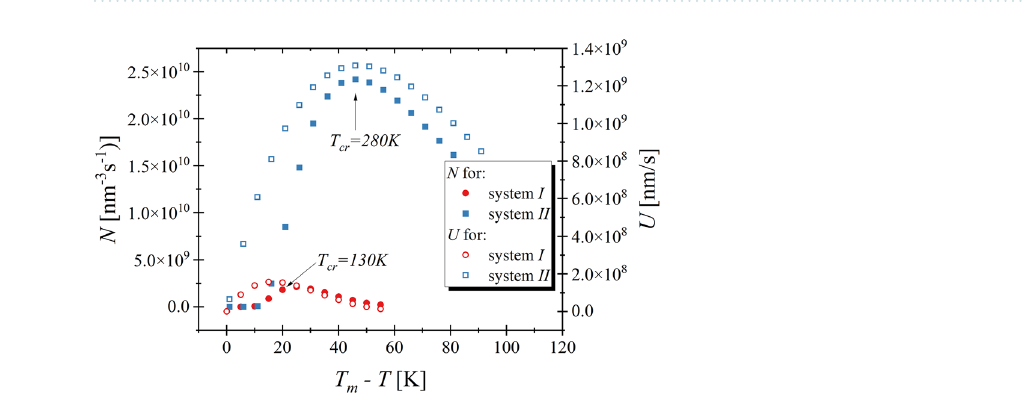
Figure 3. The values of the nucleation and crystal growth rates for different temperatures are shown. The arrows indicate N and U value obtained at the temperature at which the studied RM system crystallized during